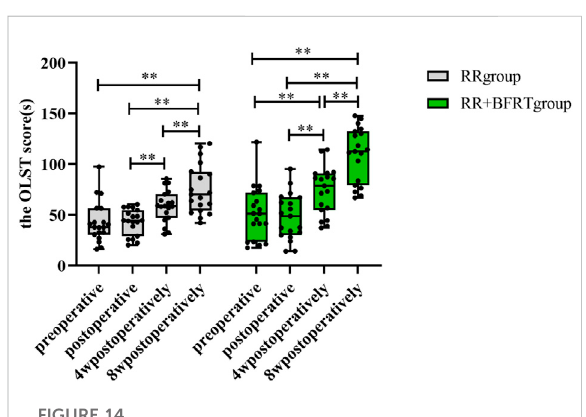
FIGURE 14 Intra-group comparison of OLST scores in the RR group and the RR + BFRT group. “ ** ” indicates a signi fi cant change ( p < 0.01). Values are presented as interquartile range. RR Group: routine rehabilitation group; RR + BFRT Group: routine rehabilitation + blood fl ow restriction training group.